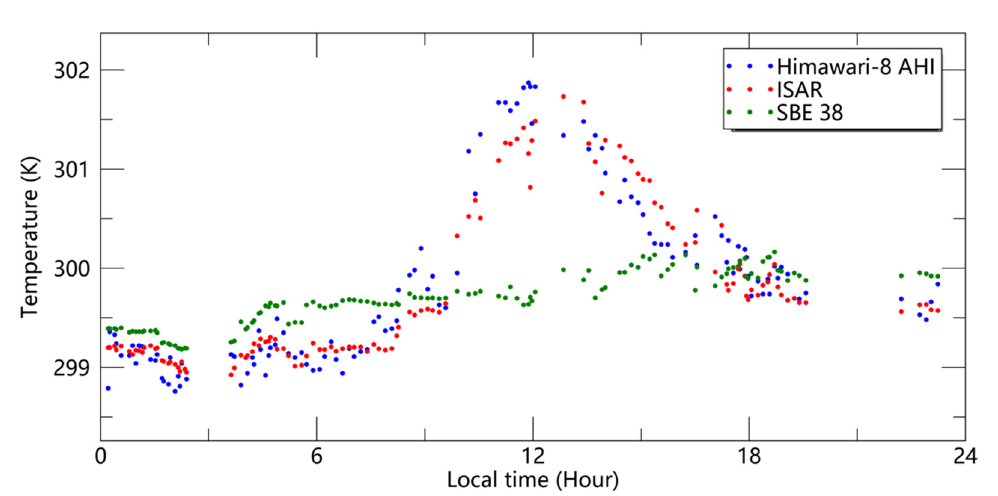
Figure 6. Matchups (red: ISAR skin SST, green: SBE 38 bulk SST, blue: Himawari-8 AHI skin SST) on 12 th October 2016 against local time.